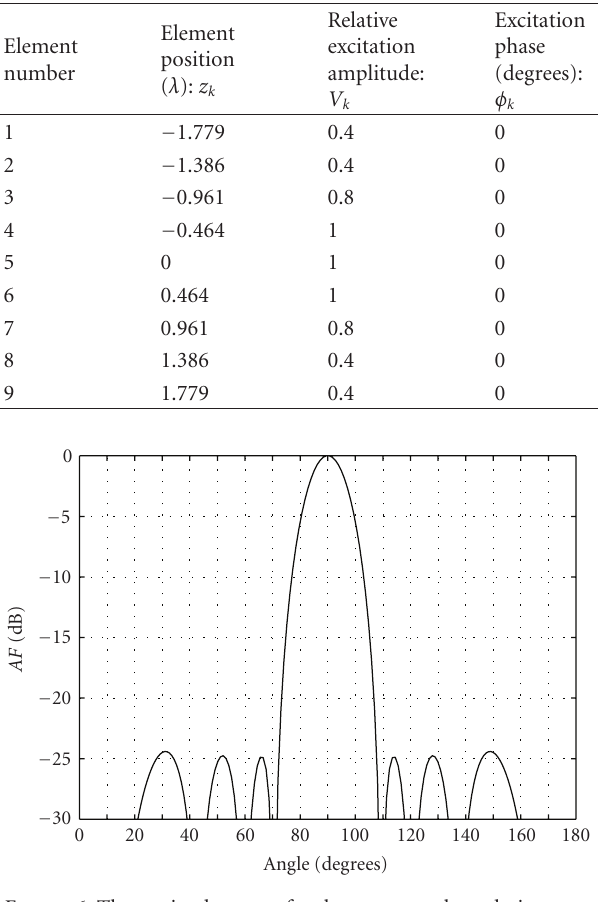
Table 4: Details on the constant phase design case.